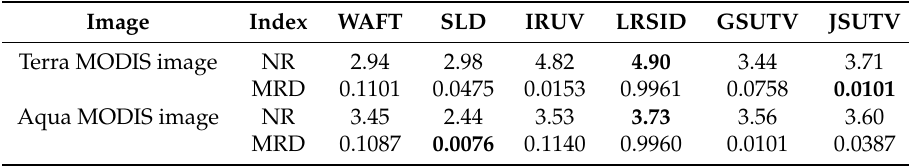
Figure 11. Destriping results of the Aqua MODIS image. ( a ) Degraded image; destriping images by: ( b ) WAFT; ( c ) SLD; ( d ) IRUV; ( e ) LRSID; ( f ) GSUTV; ( g ) JSUTV. Table 4. Quantitative results on real data using NR and mean relative deviation (MRD).